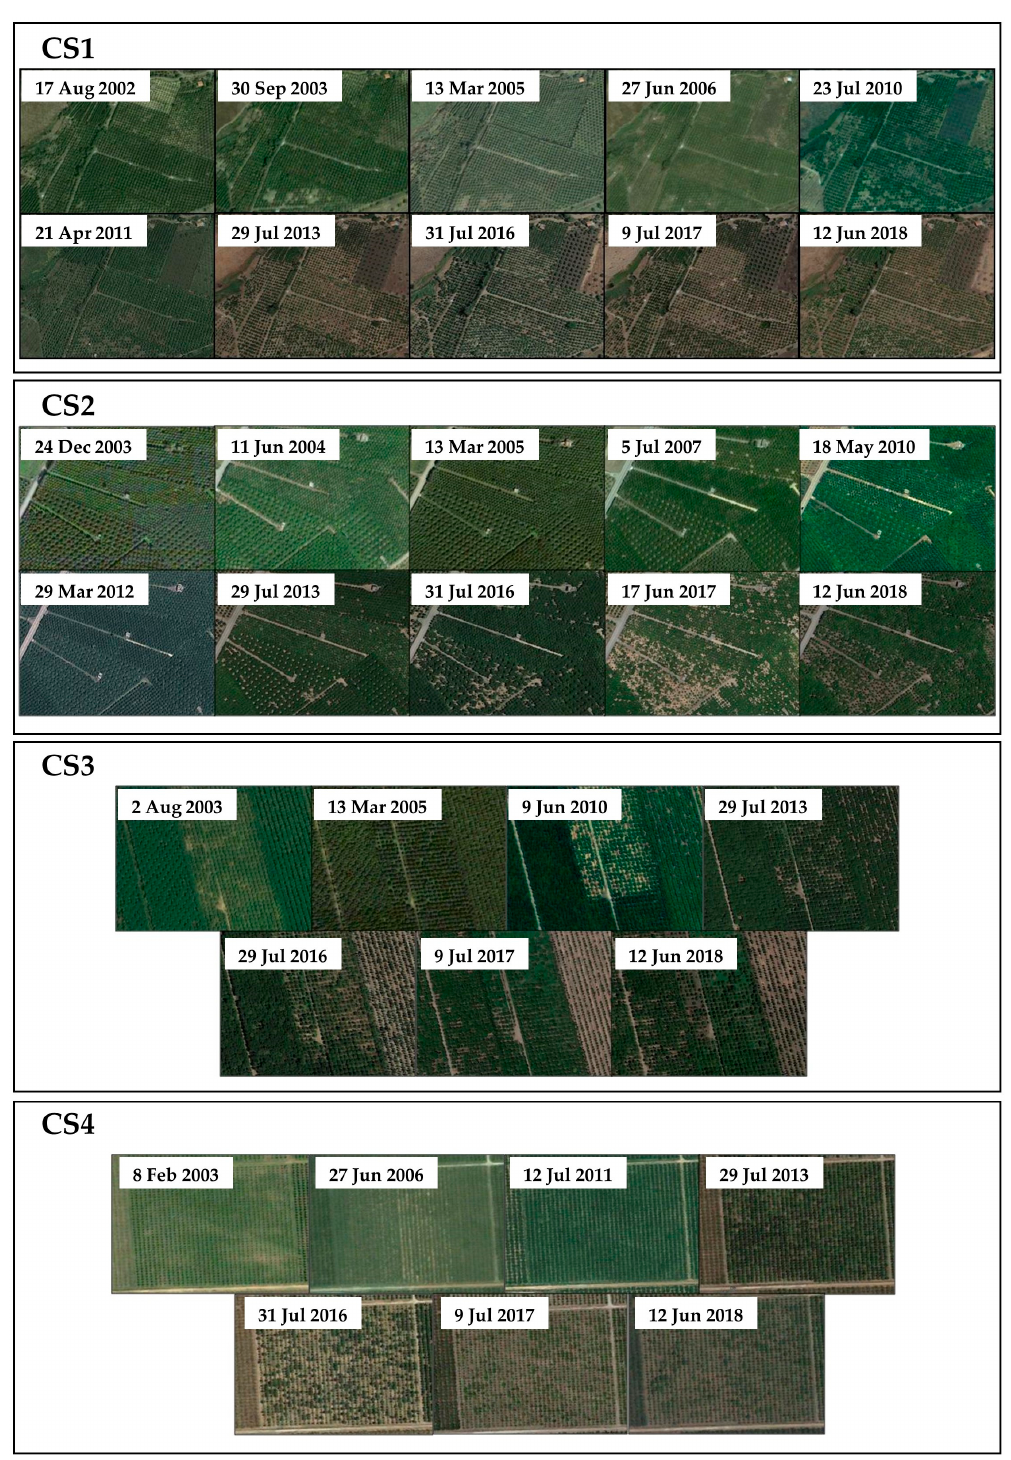
Figure 4. Satellite images by Google Earth for CS1–CS4.